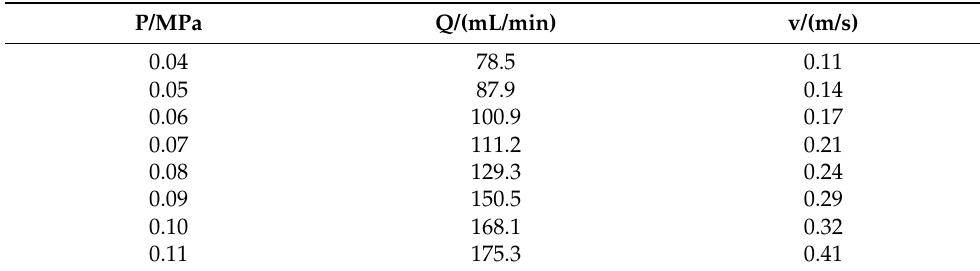
Figure 2. Illustration of experimental setup. Table 1. Experimental water productivity and velocity at different pressures.